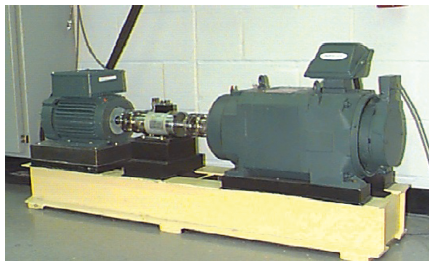
Figure 4: Test rig of rolling